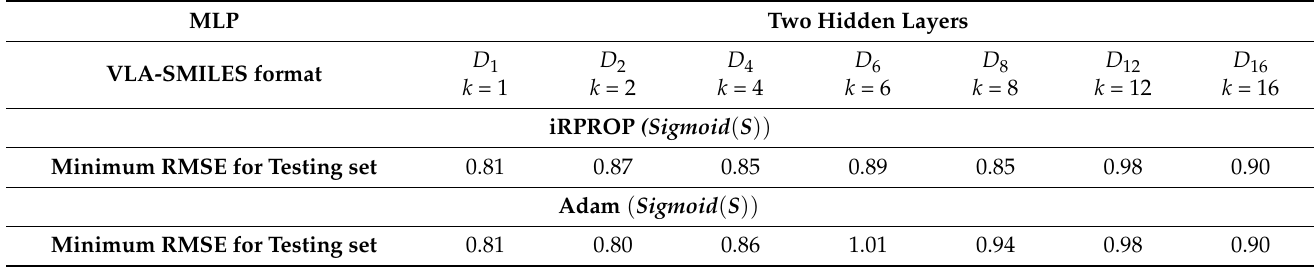
Table 4. RMSE values for testing sets for MLP with two hidden layers using iRPROP − and